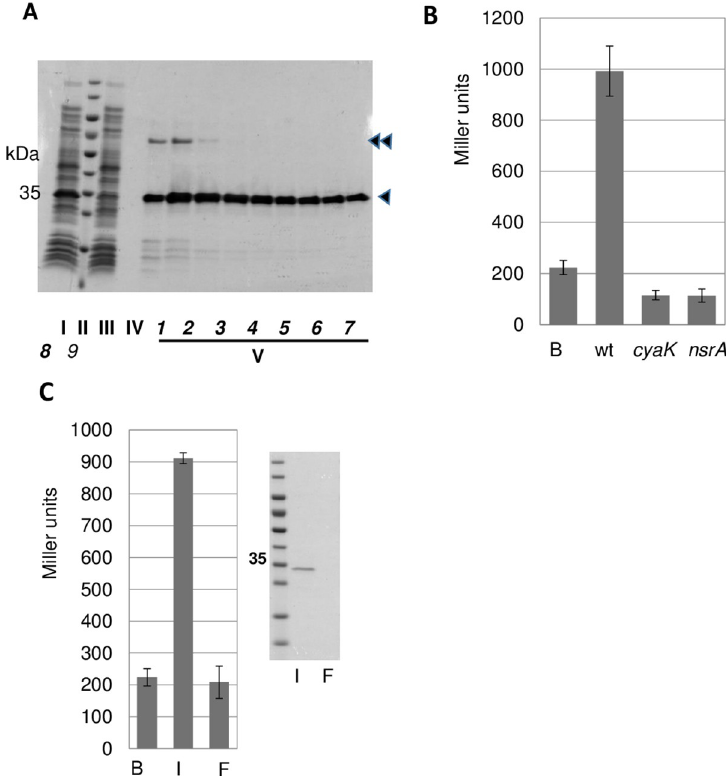
Fig 4. Purified MtRPuL2A-Strep-tag 1 has signal activity. Panel A: SDS-PAGE monitoring of MtRPuL2A-Strep- tag 1 purification. I: E . coli crude extract of a MtRPuL2A-Streptag 1 overexpressing strain; II-Molecular weight marker; III-Flow-through of the Strep-Tactin 1 column; IV-Last wash step of the Strep-Tactin 1 column; V-fractions obtained after elution with 5mM D-desthiobiotin. The simple and the double arrowheads point to the MtRPuL2A-Streptag protein and the E . coli GroEL protein, respectively. Panel B : activity of pooled purified fractions (V6 to V9; 4-fold dilution) after the Strep-Tactin 1 column in wild type (GMI12052), cyaK (GMI12071) and nsrA (GMI12072) reporter strains. B buffer control. Panel C : Fiberglass depletion assay of the strep-Tactin purified MtRPuL2A-Streptag protein (7 μ g). The signal activities of the input (I) and flow-through (F) fractions of a fiberglass column on a wt S . meliloti reporter strain are shown. B buffer control. Right: Western blot control using an anti-strep- tag antibody. Activities are the mean of two independent experiments. Error bars feature SE.